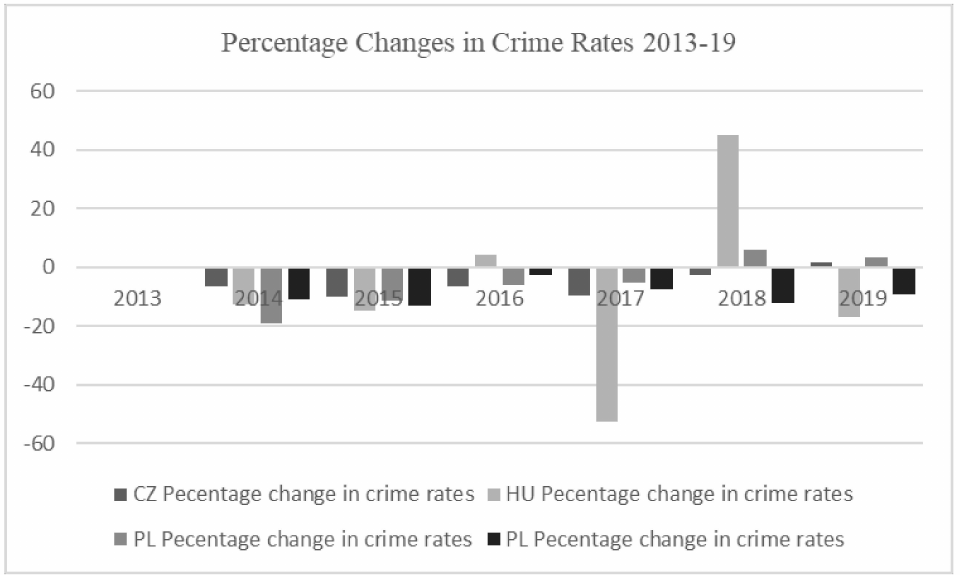
Figure 3. Changes in the crime rate of V4 countries (per 100,000 population) for 2013–2019. Source: See Table